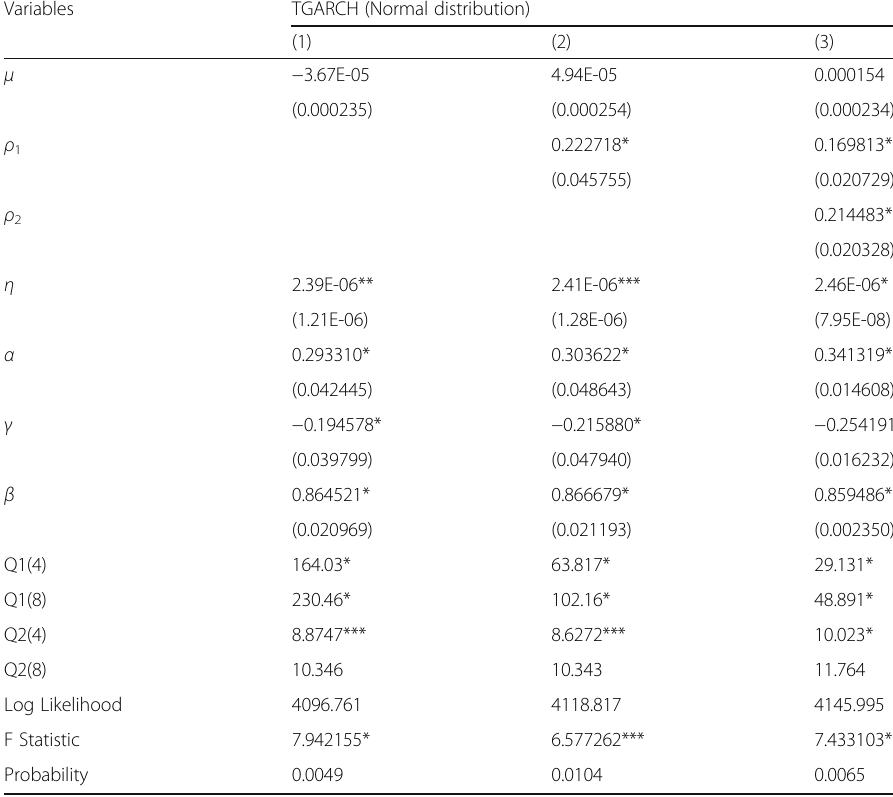
Table 5 Estimation results for TGARCH model Variables TGARCH (Normal